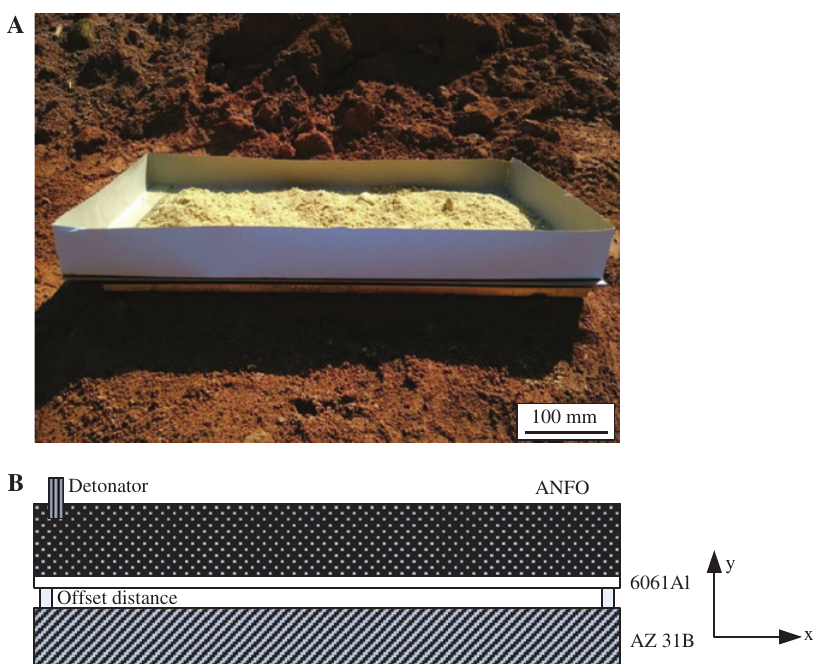
Figure 2: The device of preparation for the explosive welding. (A) Scene drawing of the explosive welding; (B) schematic drawing of the explosive